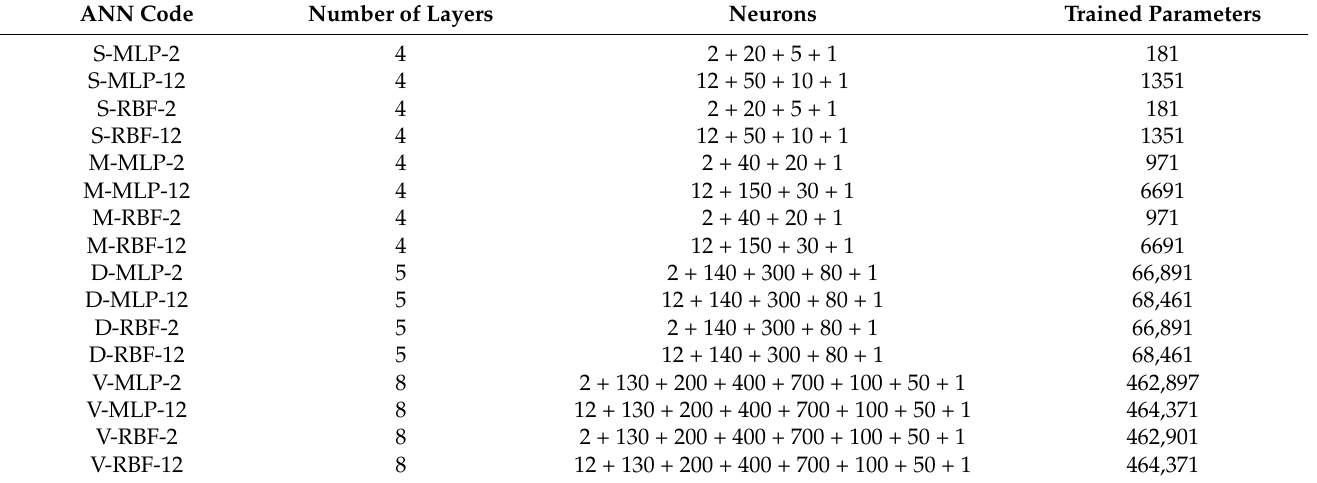
Table 7. Input and output variables of datasets implemented in both MLP and RBF neural network